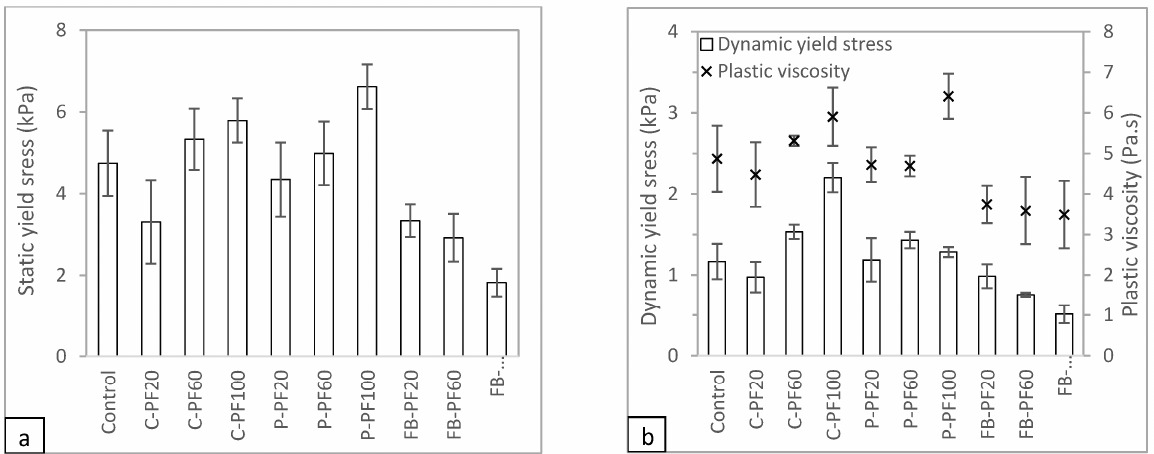
Figure 9. ( a ) Static yield stress and ( b ) dynamic yield stress and plastic viscosity results of mixtures prepared with the packing factor method.